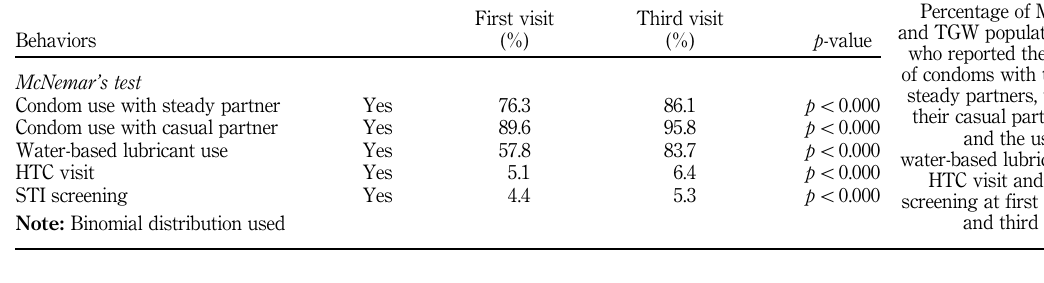
Table III. Percentage of